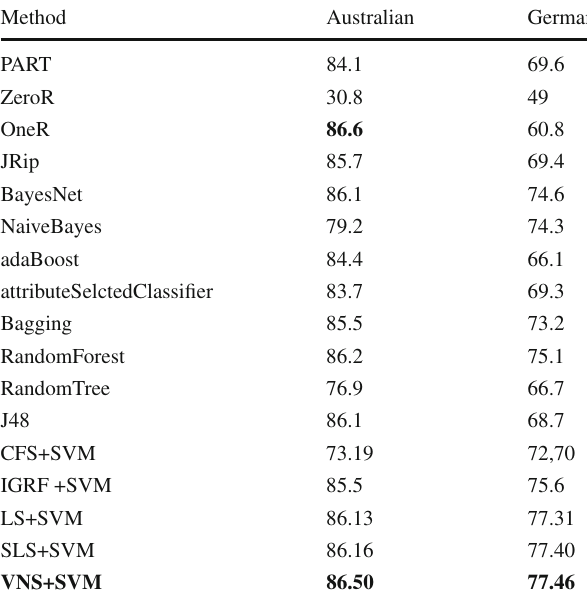
Table 10 A comparison according to the average classification accu- racy